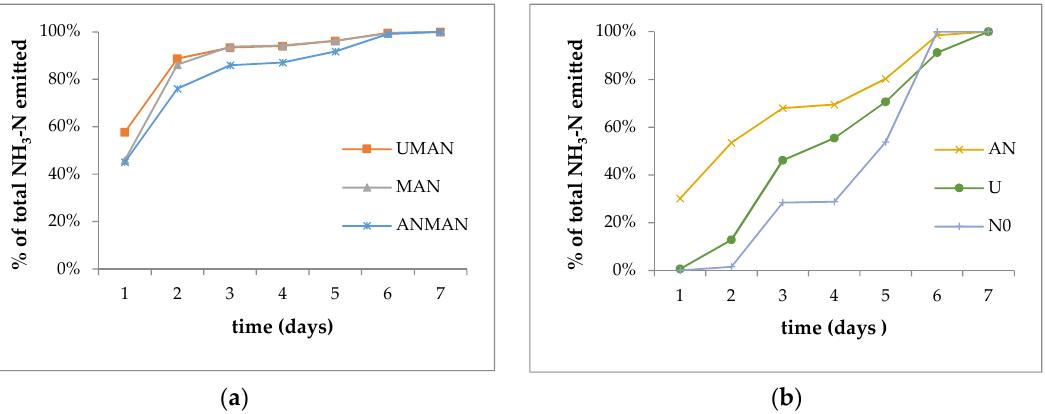
Figure 3. NH 3 -N emission dynamics (percentage of the total NH 3 -N emitted by day). ( a ) Emissions dynamics from UMAN, MAN, and ANMAN. ( b ) Emissions dynamics from AN, U, N0. U: Urea; AN: Calcium ammonium nitrate; MAN: Dairy manure; ANMAN: AN + MAN; UMAN: U + MAN; N0: Control.